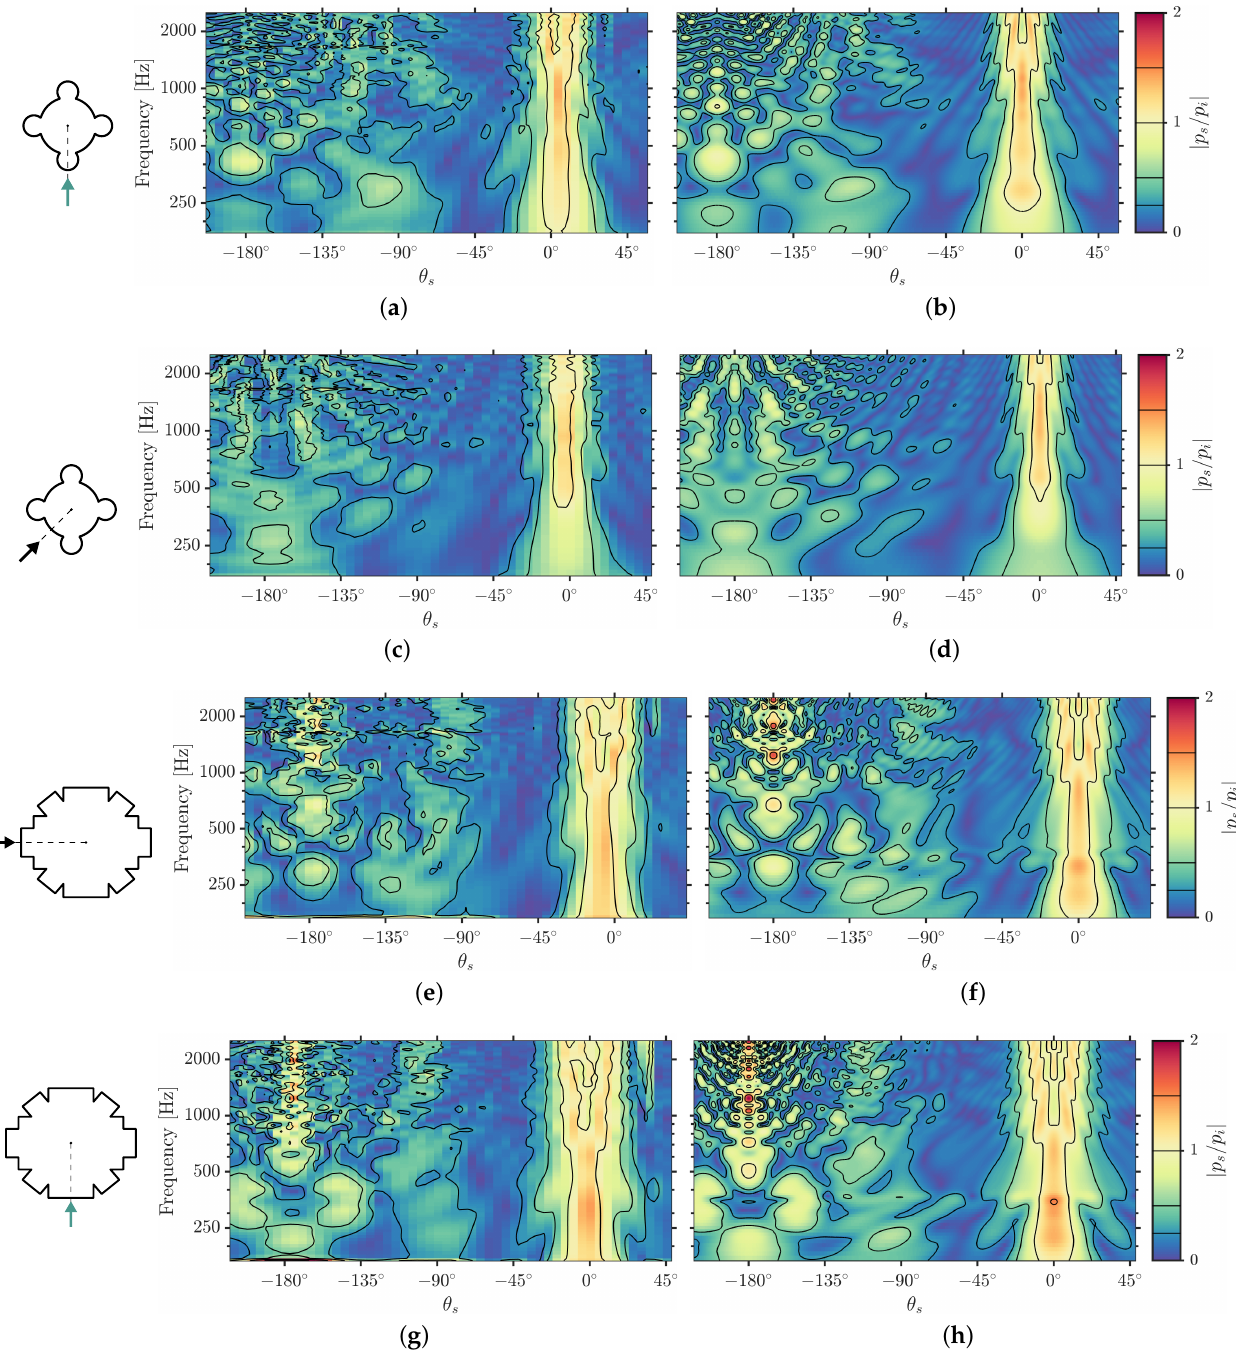
Figure A1. | p s / p i | for the compound piers N1 with ( a , b ) θ 0 = 90° and ( c , d ) θ 0 = 45°, and C1 with ( e , f ) θ 0 = 0° and ( g , h ) θ 0 = 90°. Scale model measurements ( left ) compared to simulations ( right ). The frequency axis of the measurements is scaled according to the factors given in Table